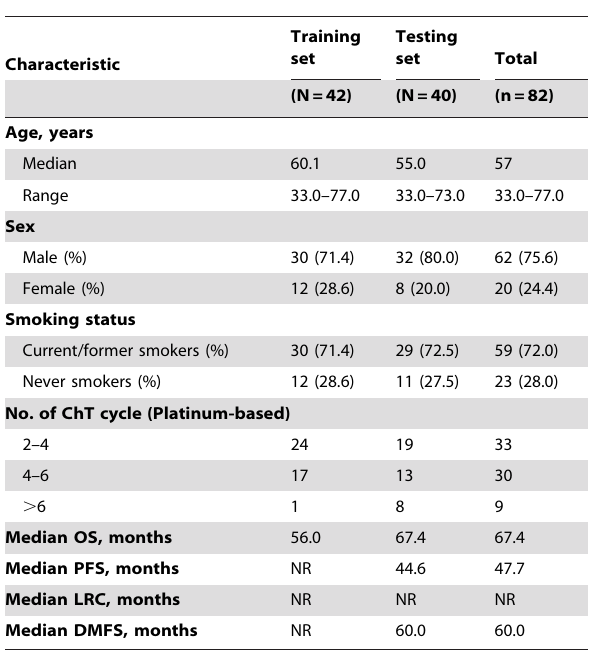
Table 1. Clinical characteristics of the LD-SCLC patients.